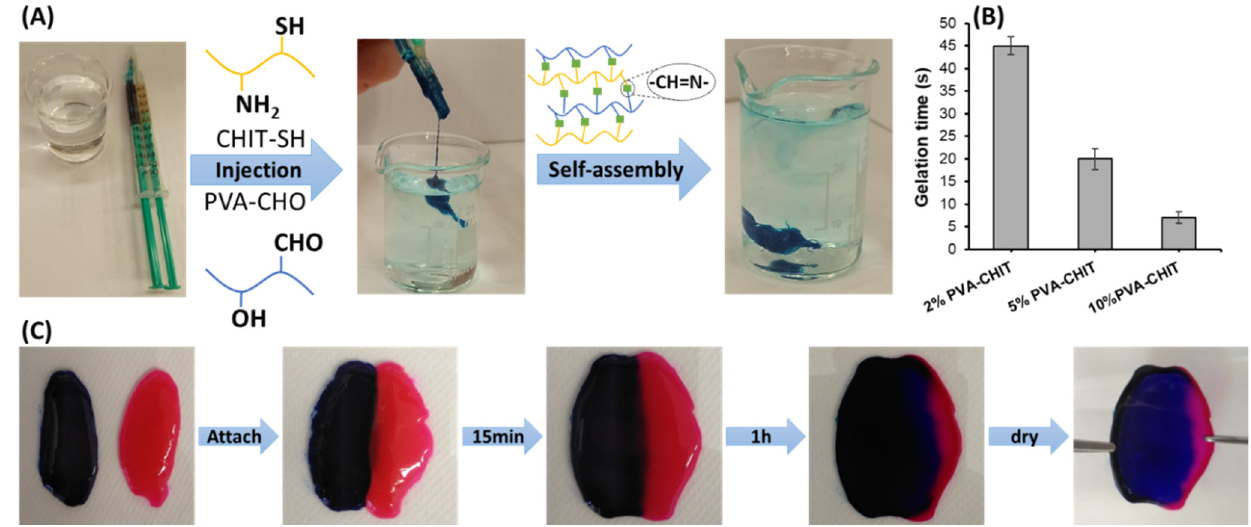
Figure 8. ( A )The self-assembly of injectable hydrogel (7% w / v ) with methylene blue dye in PBS buffer solution (pH 7.4), ( B ) the gelation time of the PVA-CHO/CHIT-SH hydrogel as a function of hydrogel concentration, and ( C ) the self-healing properties of the prepared hydrogel (2% w / v ).